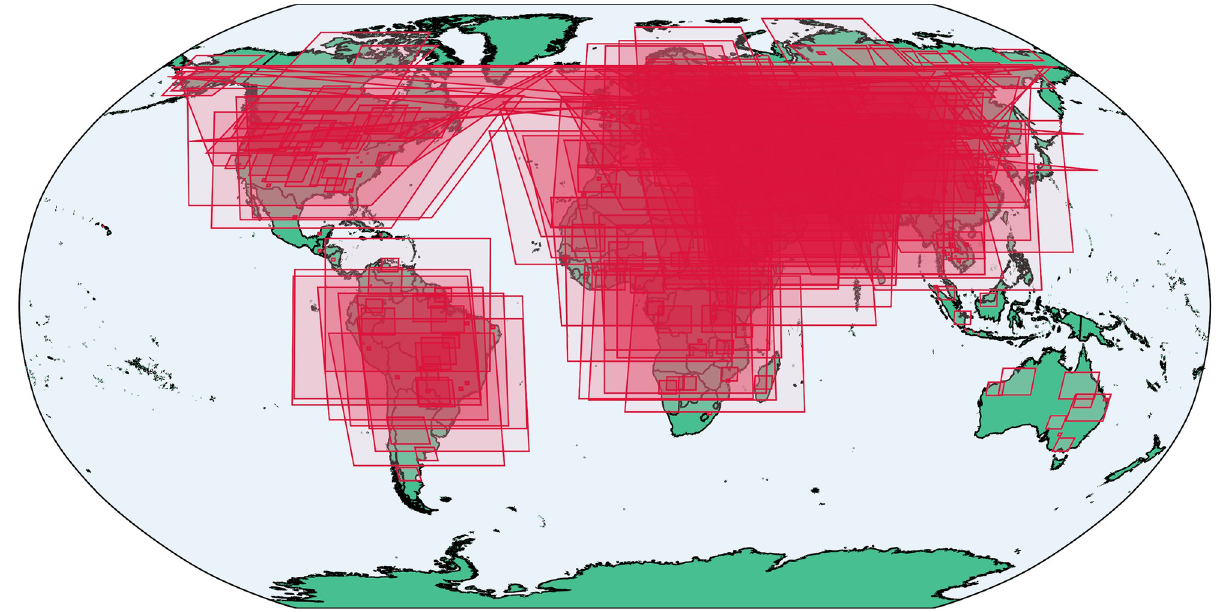
Fig 5. Bounding boxes of the simulated map scenes. The geodata used to render country outlines is from © Natural Earth data and is in the public domain.